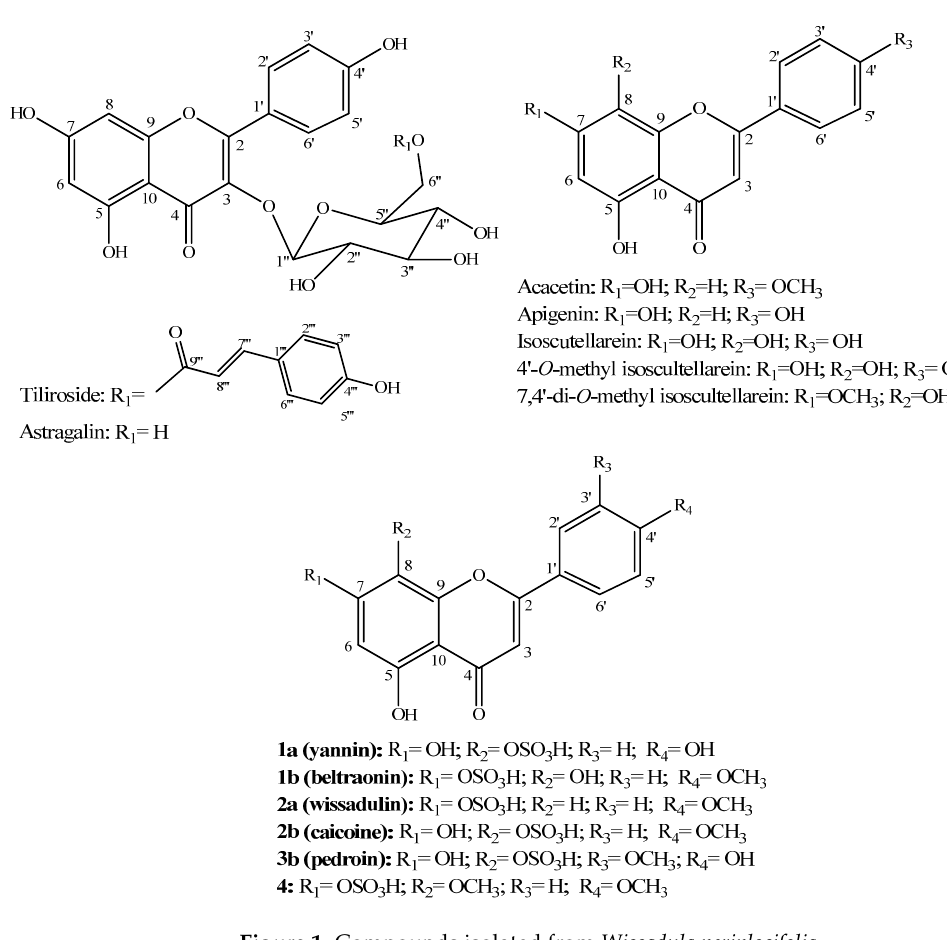
Figure 1. Compounds isolated from Wissadula periplocifolia.